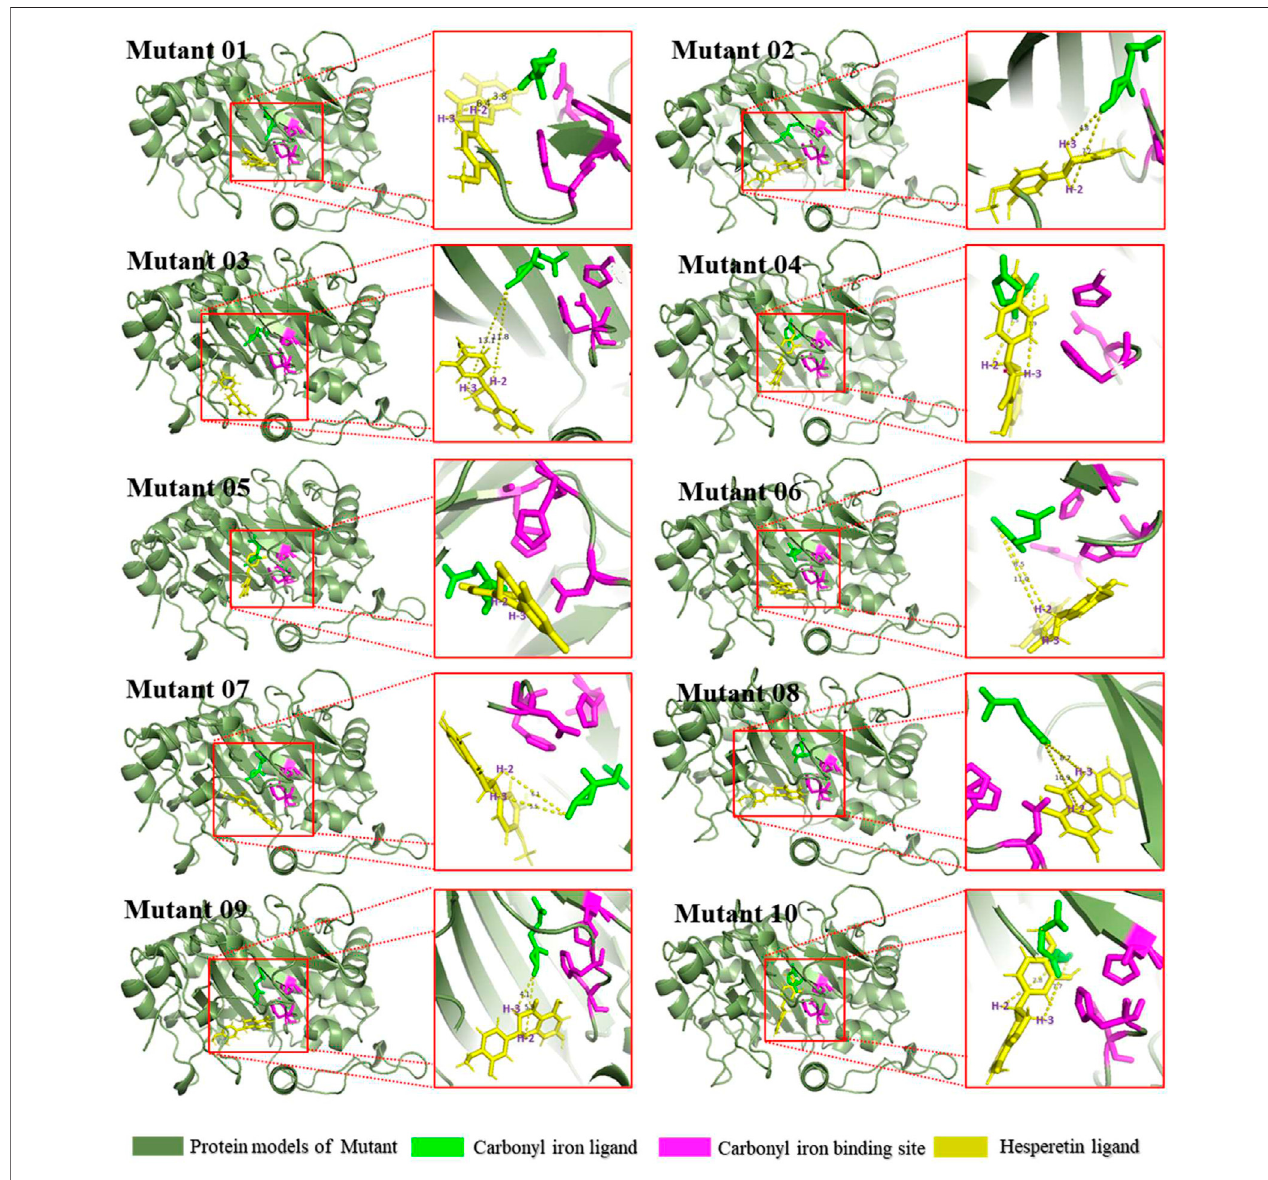
FIGURE 8 | Binding conformations of substrates and